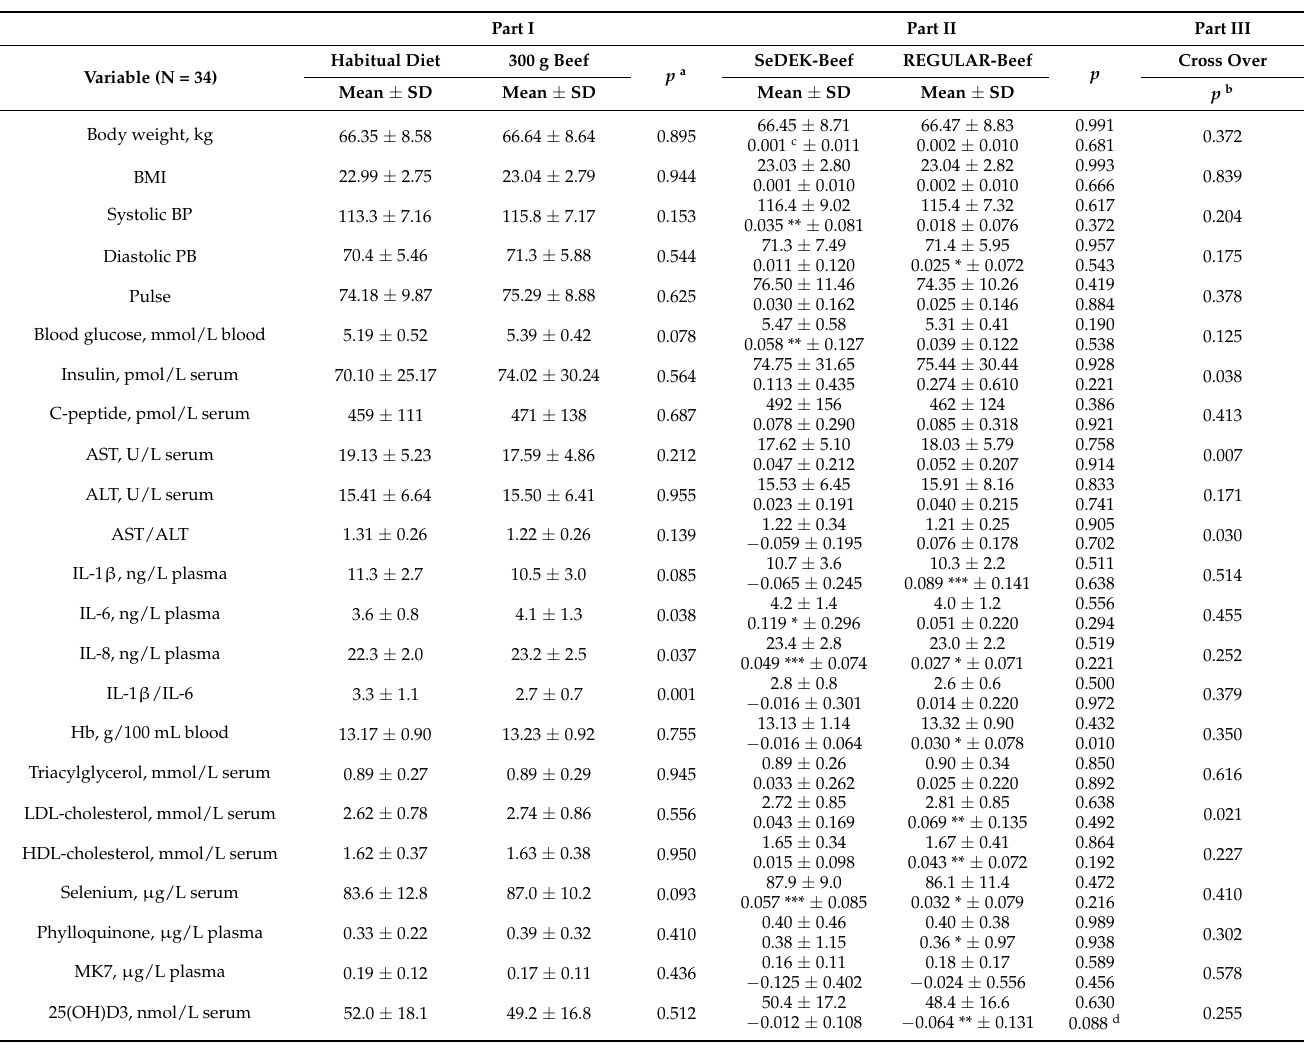
Table 4. Participant characteristics, anthropometric values, and serum analyses of 34 participants. Part I shows habitual and the ‘300 g beef’ meat diets. Part II shows the 2 different meat diets in absolute values (upper part of cell) and as changes (lower part of cell). Part III tests for an effect of the 2 meat products’